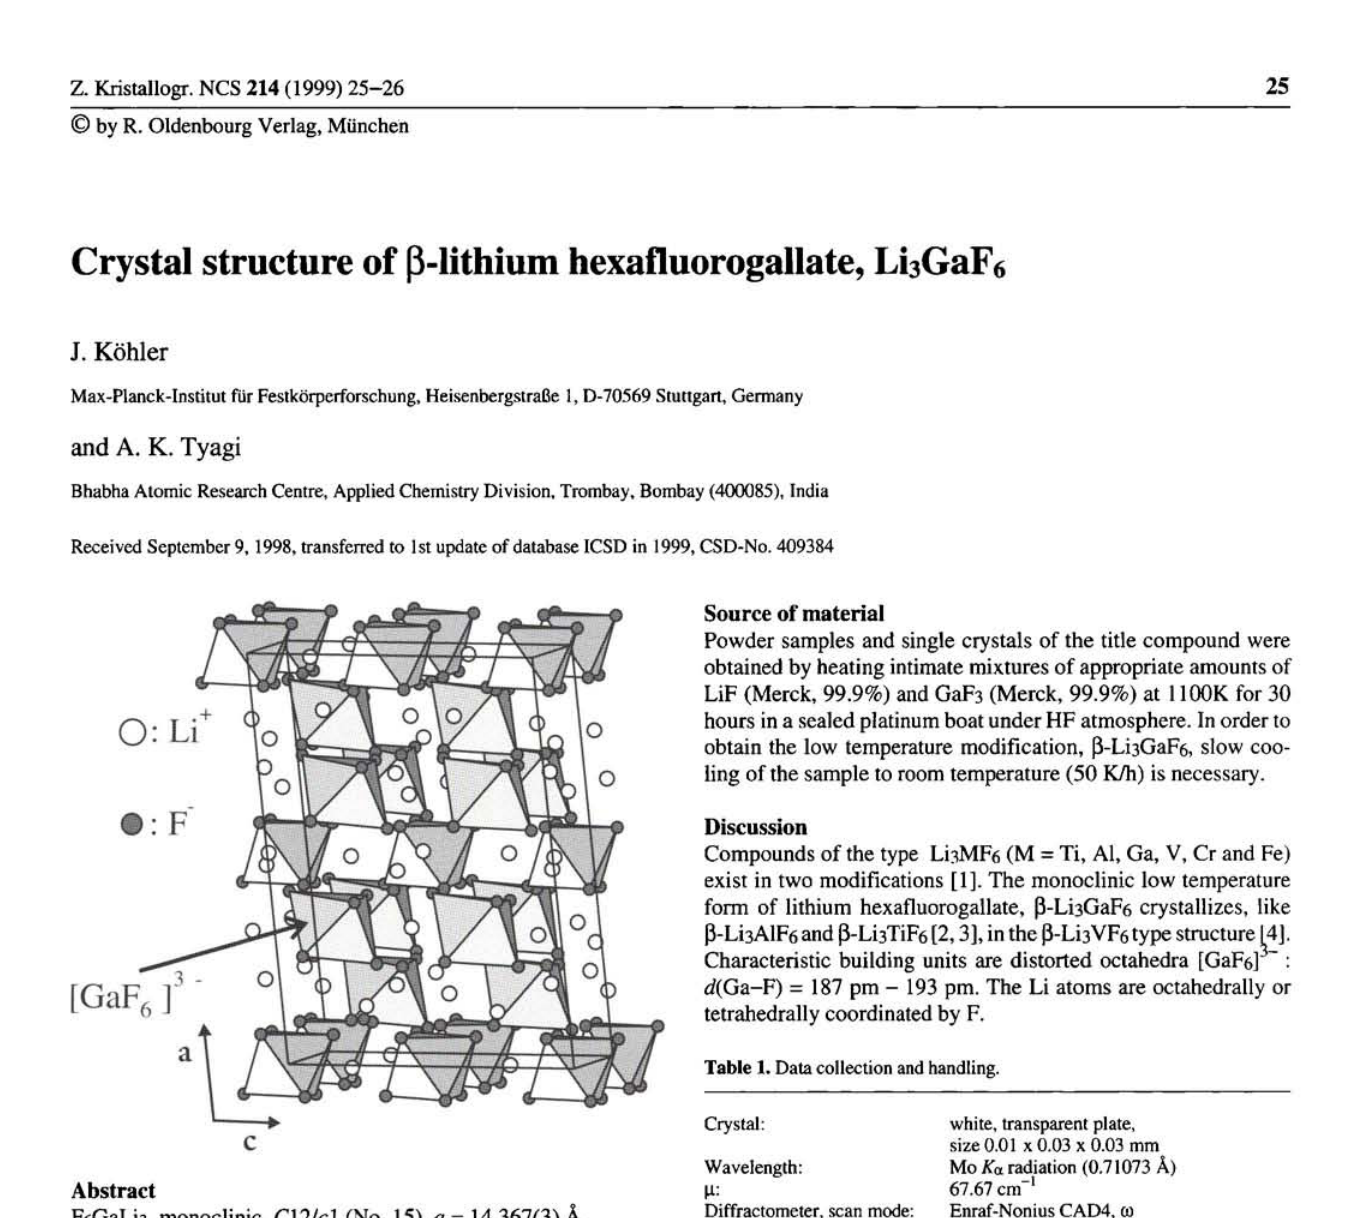
Table 2. Atomic coordinates and displacement parameters (in Â 2